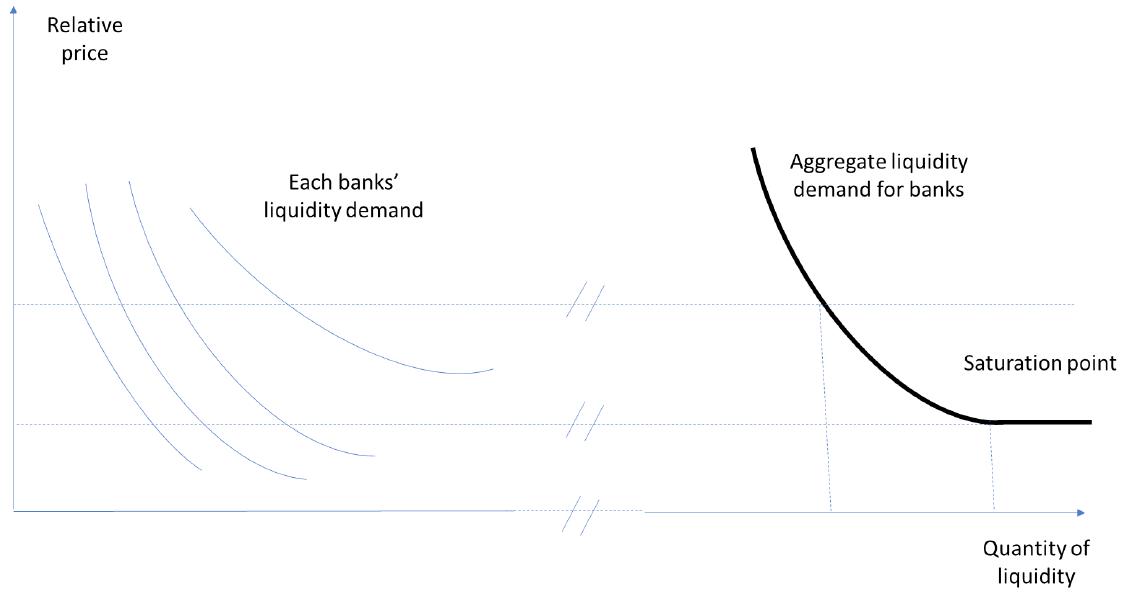
Figure 1. Theoretical derivation of the aggregate liquidity